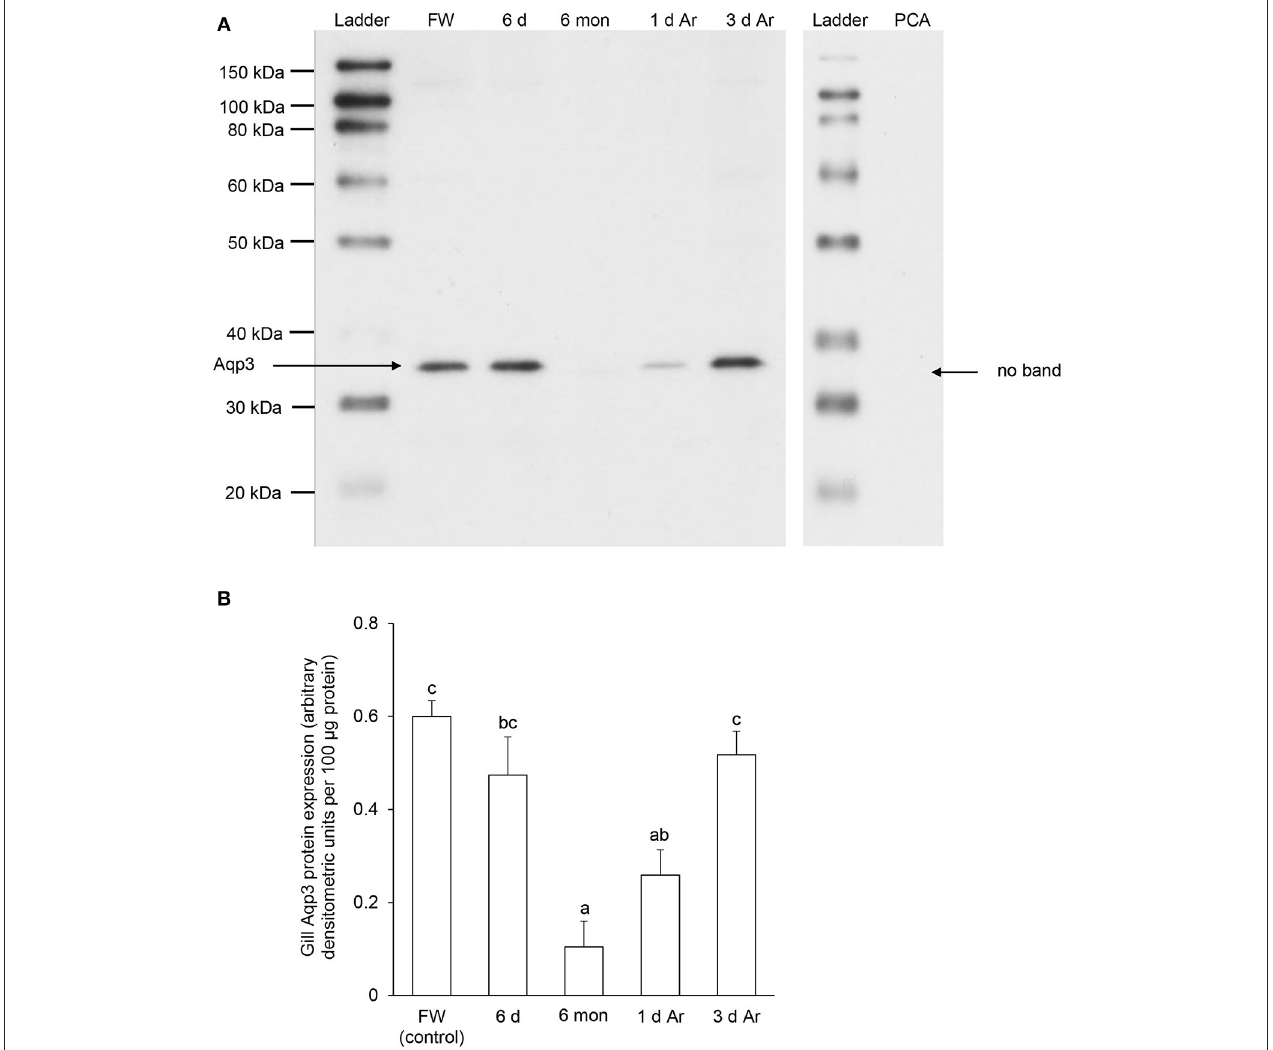
FIGURE 9 | The protein abundance of aquaporin 3 (Aqp3) in the gills of Protopterus annectens kept in fresh water on day 0 (FW; control), after 6 days (d; induction phase) or 6 months (mon; maintenance phase) of aestivation, or after 1 or 3 d of arousal (Ar) from 6 mon of aestivation. (A) An example of immunoblot of Aqp3 (left) and Aqp3 preincubated with immunising peptide for the peptide competition assay (PCA; right). (B) The protein abundance of Aqp3 expressed as arbitrary densitometric units per 100 µ g protein. Results represent mean ± S.E.M. ( N = 3). Means not sharing the same letter are significantly different ( P <